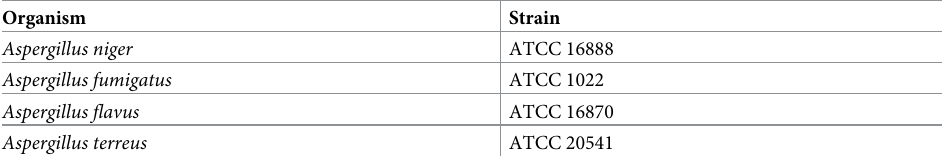
Table 1. Aspergillus strains used in this